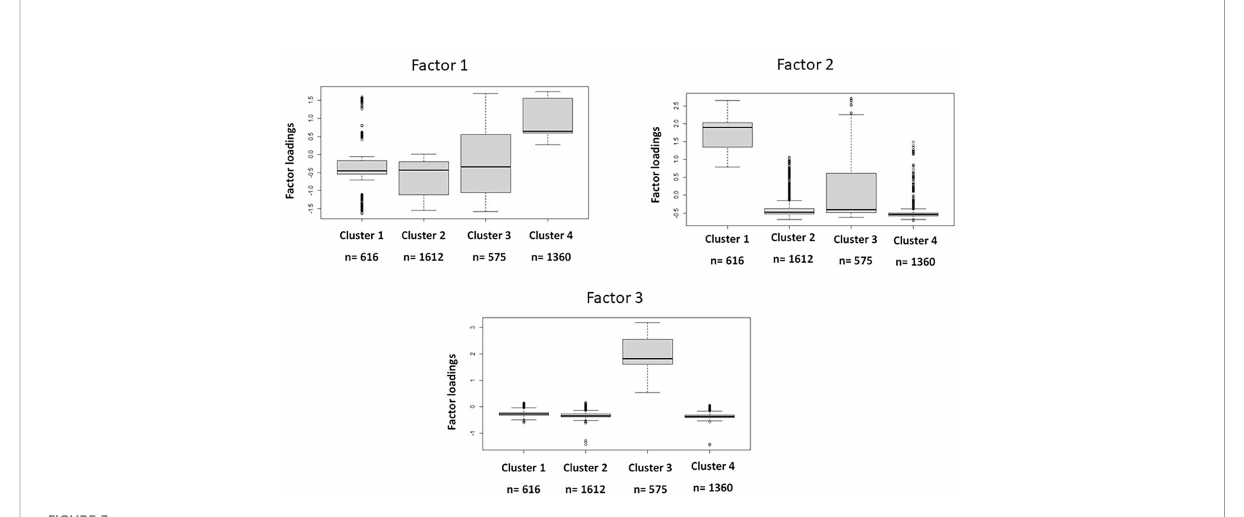
FIGURE 3 Differences between cluster for each factor.